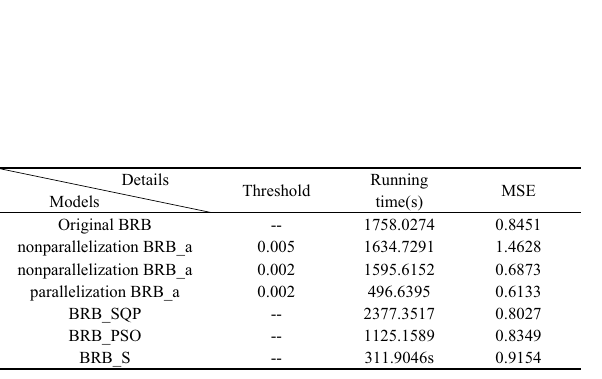
Table 16. The comparison results between different